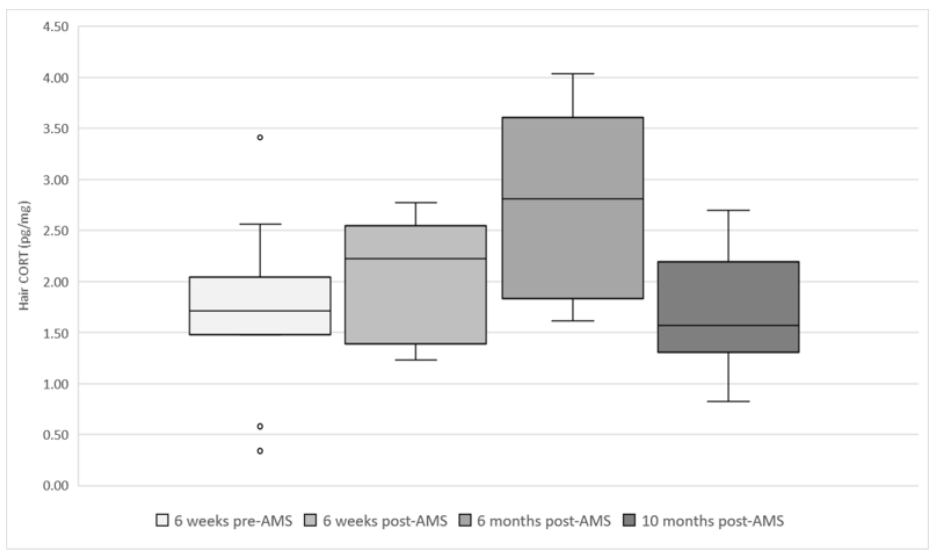
Figure 6. Box and whisker plots showing hair cortisol levels (pg/mg) at each sampling session (total samples = 47) in evaluated cows ( n = 12) from six weeks before AMS installation (January 2018) to 10 months (November 2018) after AMS installation.